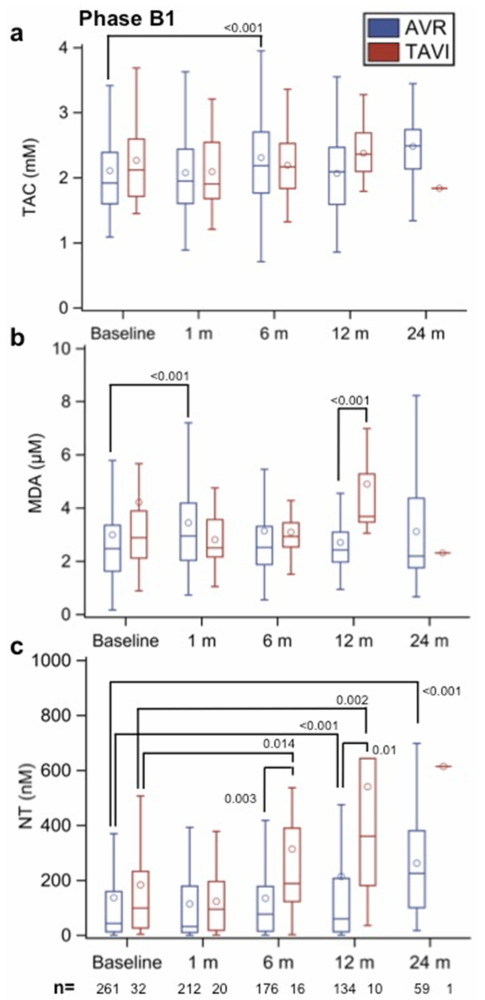
Figure 3. ( a ) Total antioxidant capacity (TAC, in mm), ( b ) malondialdehyde (MDA, in µ m), and ( c ) nitrotyrosine (NT, in nm) values in Phase B1 patients with aortic biological heart valves (BHVs) only made of pericardial tissues implanted surgically (AVR) and by transcatheter aortic valve implantation (TAVI) at different time points (baseline and 1, 6, 12, and 24 months after implantation). The